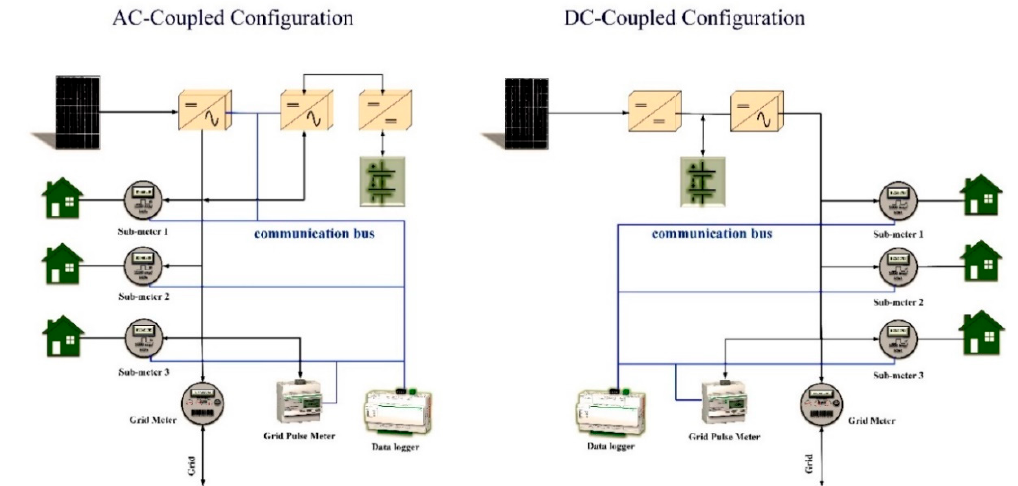
Figure 2. AC-coupled ( left ) and DC-coupled ( right ) configurations used in the study.